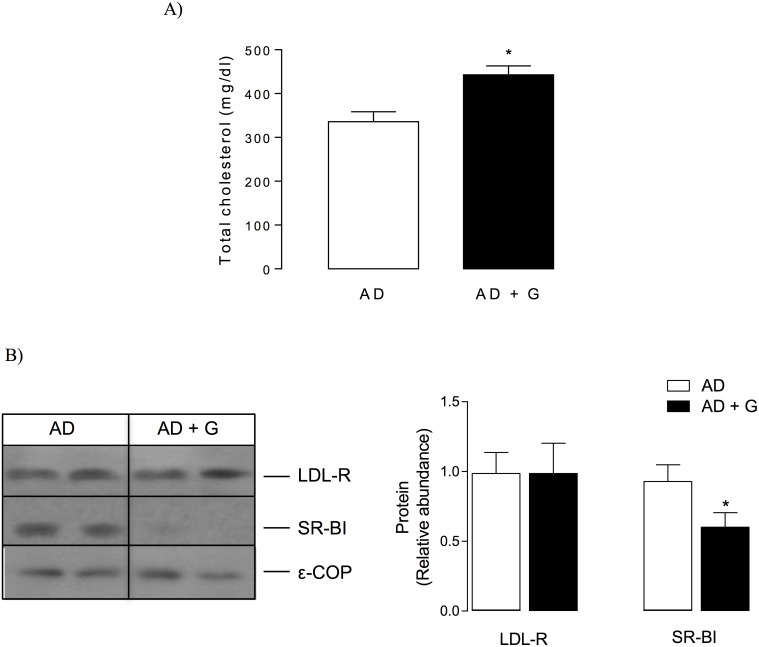
Effect of gugulipid on plasma cholesterol and hepatic SR-BI and LDL receptor (LDL-R) level in male ApoE KO mice.(A) Plasma total cholesterol and (B) western blot analysis (left) and quantitation (right) of hepatic LDL-R and SR-BI in control atherogenic diet-fed and gugulipid-treated atherogenic diet-fed mice. AD: atherogenic diet; G: gugulipid. Two independent experimental sets were used; n = 6 in each set. Values represent mean ± SD. *P<0.05.